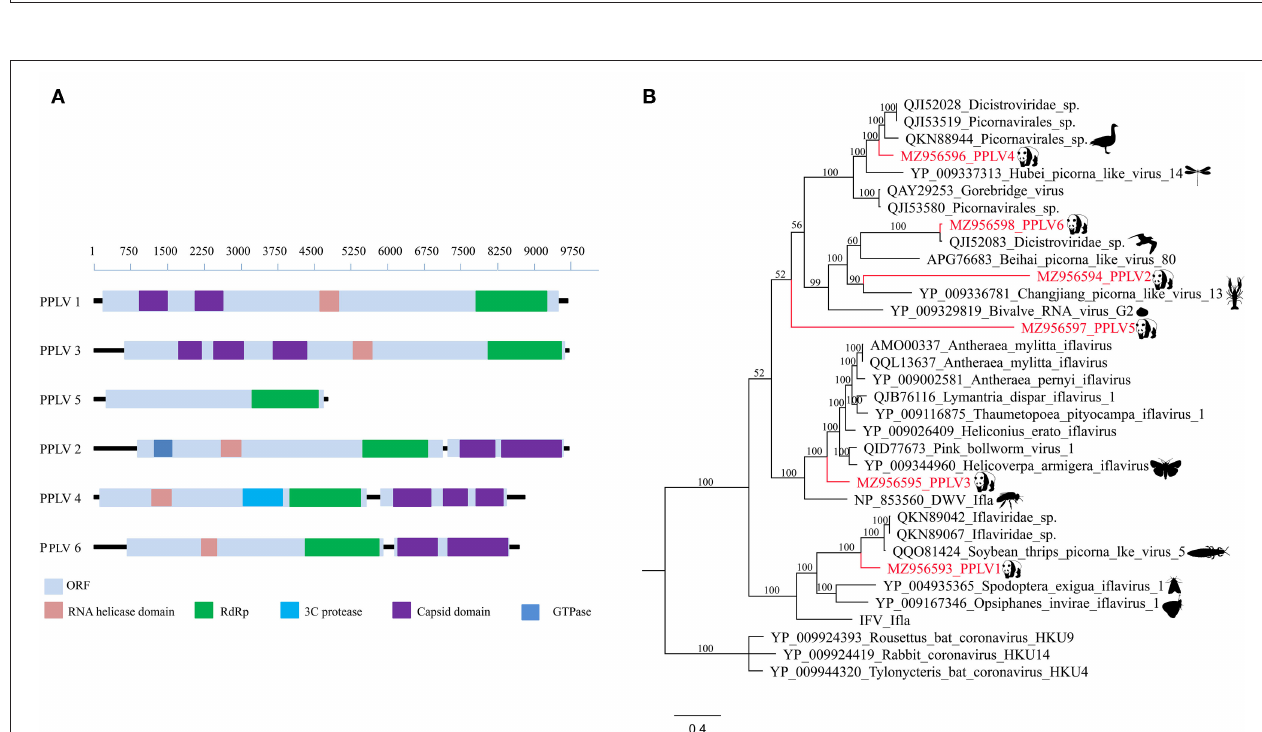
Frontiers in Veterinary Science | www.frontiersin.org